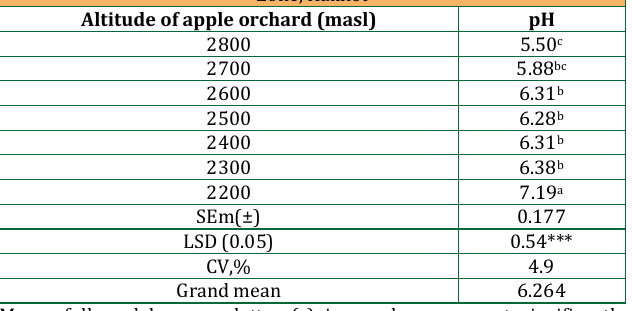
Table 5: pH variation in different altitude apple orchards in Apple Zone, Kalikot